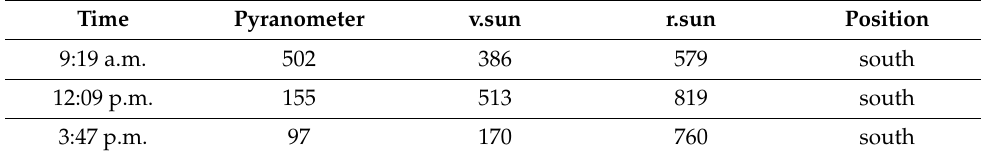
Figure 8. Solar irradiance at the Municipal Swimming Pool on 23 June 2021 (W/m 2 ) at ( A ): 9:19 a.m., ( B ): 12:09 p.m., and ( C ): 3:47 p.m. The black circle represents the measurement location.